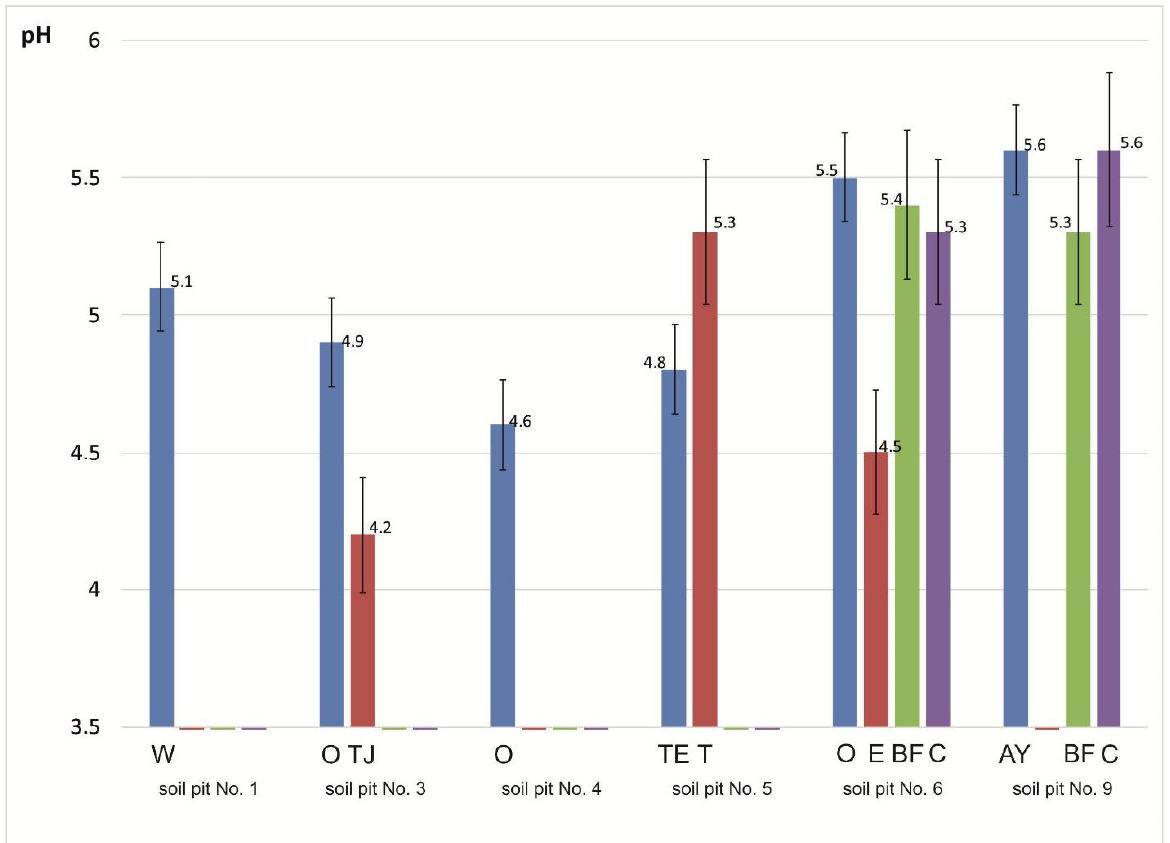
Figure 7. The pH in fallow soils on Gogland: soil pit No. 1 — humus petrozem formed on rock material (Leptosol (Humic) — WRB); soil pit No. 3 — dry-histic lithozem formed on rock material (Histic Leptosol — WRB); soil pit No. 4 — petrozem formed on rock material (Leptosol — WRB); soil pit No. 5 — sandy loam histic-podzol-eluvozem formed on a bouldery moraine (Histic Cambisol — WRB); soil pit No. 6 — illuvial – ferruginous podzol formed on a sandy loam bouldery moraine (Albic Podzol — WRB); soil pit No. 9 — gley soddy podbur on stratified marine sandy-loamy sediments (Entic Stagnic Tidalic Gleyic Podzol — WRB). Soil horizons: W — incipient humic horizon; O — litter; TJ — dry peat horizon; TE — eutrophic horizon; T — peat horizon; AY — gray humic horizon; E — podzolic horizon; BF — illuvial-rusty horizon; С— soil-forming rock.